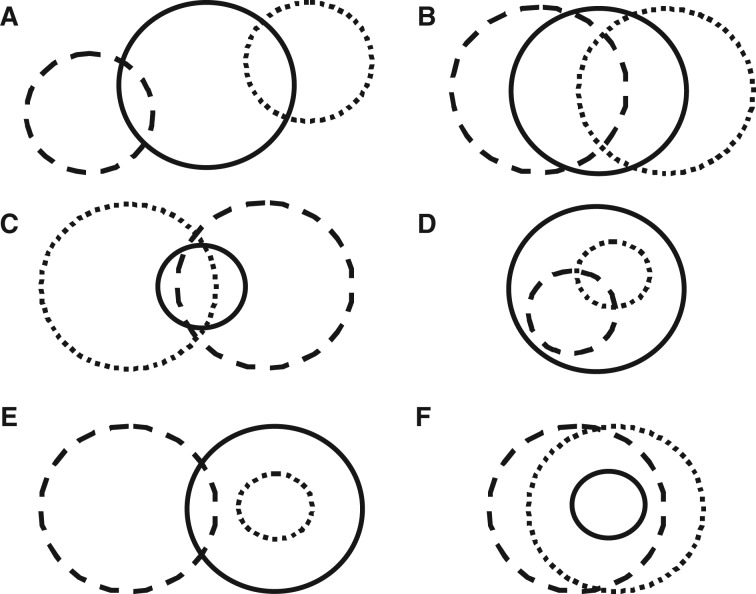
Example of the distribution of multiple alien plant species (dashed and dotted lines) relative to the distribution of a native plant (solid line), in which (A) there is partial overlap on the margins of their respective distributional limits; (B) major overlap including core distribution of the native species; (C) there is complete overlap; (D) the distribution of both alien plants is a subset of that of the native; (E) the distribution of one alien is a subset of the native's and the other alien has partial distribution overlap; and (F) the distribution of the native is a subset of that of both the alien plant species. Note: the complete overlap of individual alien plant species has not been presented.